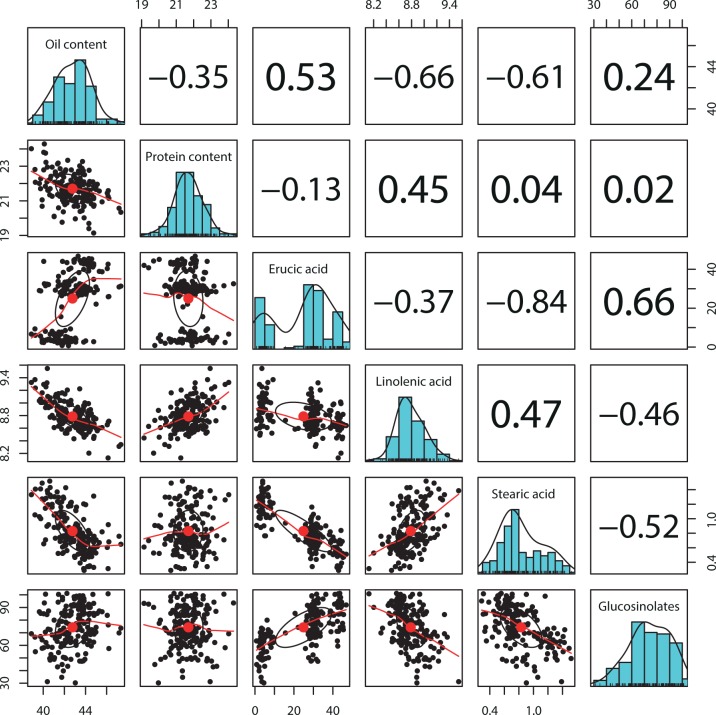
Distributions and pairwise correlations for Best Linear Unbiased Estimates of six seed traits evaluated for 202 lines of the TN DH population in multi-environmental field trials.All correlations passed significance tests with P-values less than 0.001 except for the correlation between protein content and erucic acid, glucosinolates, and stearic acid content.